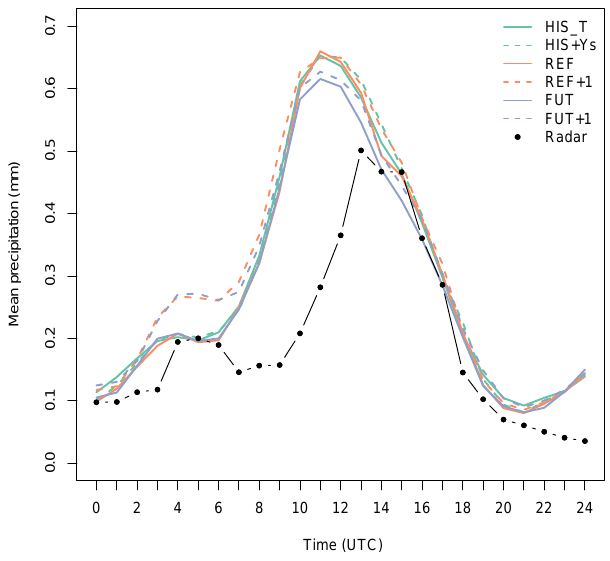
Figure 8. Diurnal cycle of mean precipitation (mmh − 1 ) over the Netherlands in the different experiments (averaged over 18 cases) and given by radar data (averaged over 14 cases).